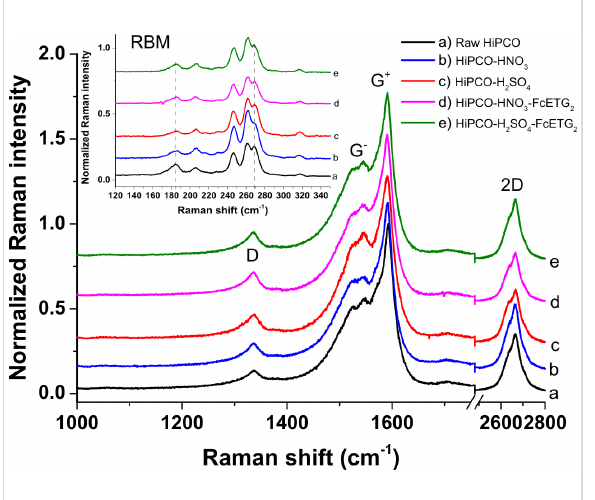
Figure 8: Raman data of raw and f-SWCNTs taken with a laser at 514 nm.